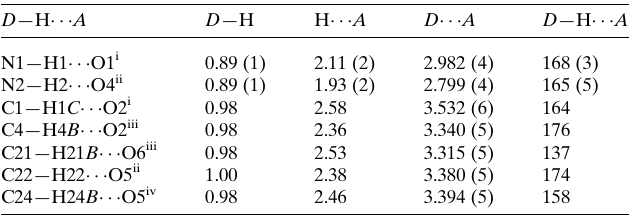
Table 1 Hydrogen-bond geometry (A˚ , (cid:3) ).